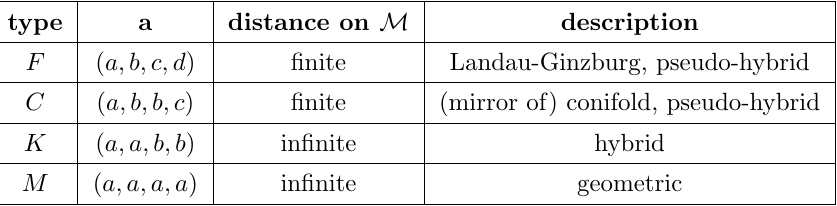
Table 1 . F -, C -, K -, and M -points of one-parameter